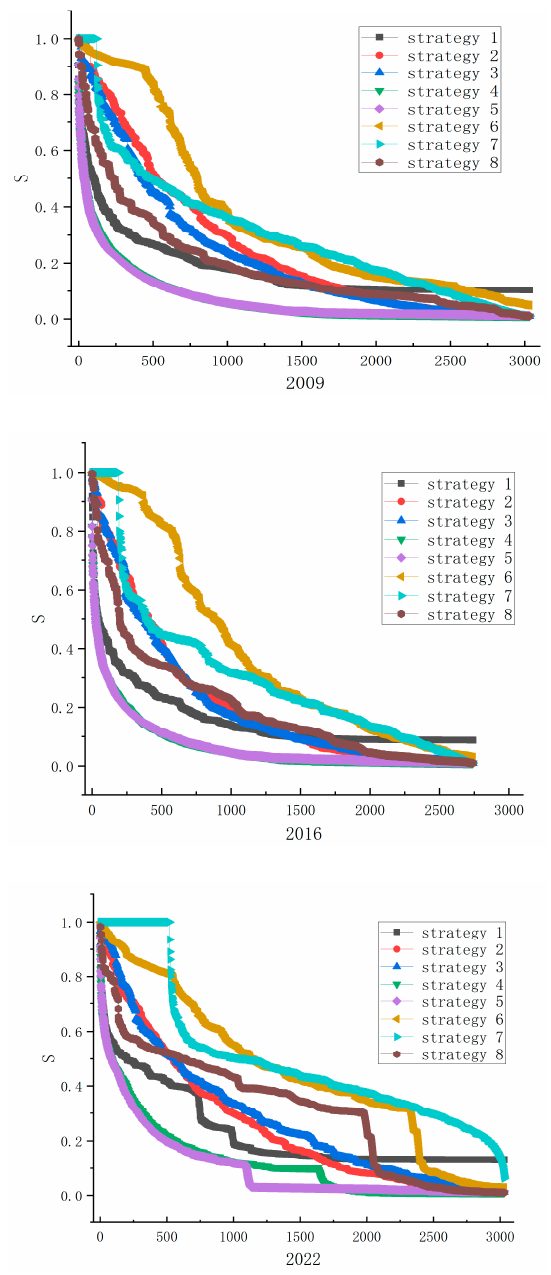
Figure 5. Resilience analysis based on rail network accessibility.